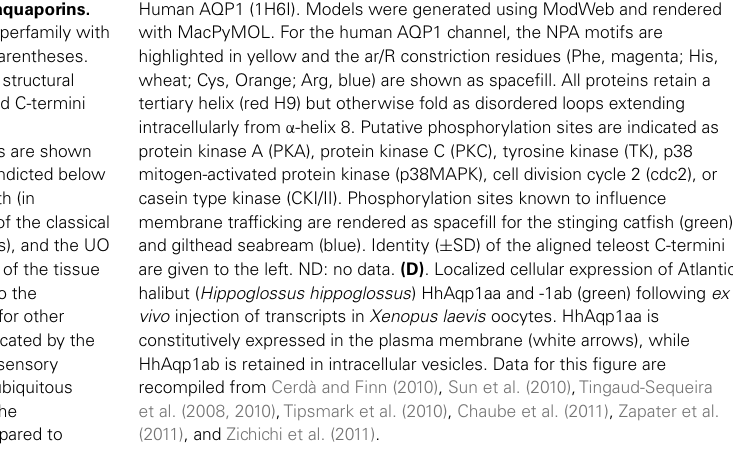
Human AQP1 (1H6I). Models were generated using ModWeb and rendered with MacPyMOL. For the human AQP1 channel, the NPA motifs are highlighted in yellow and the ar/R constriction residues (Phe, magenta; His, wheat; Cys, Orange; Arg, blue) are shown as spacefill. All proteins retain a tertiary helix (red H9) but otherwise fold as disordered loops extending intracellularly from α -helix 8. Putative phosphorylation sites are indicated as protein kinase A (PKA), protein kinase C (PKC), tyrosine kinase (TK), p38 mitogen-activated protein kinase (p38MAPK), cell division cycle 2 (cdc2), or casein type kinase (CKI/II). Phosphorylation sites known to influence membrane trafficking are rendered as spacefill for the stinging catfish (green) and gilthead seabream (blue). Identity ( ± SD) of the aligned teleost C-termini are given to the left. ND: no data. (D) . Localized cellular expression of Atlantic halibut ( Hippoglossus hippoglossus ) HhAqp1aa and -1ab (green) following ex vivo injection of transcripts in Xenopus laevis oocytes. HhAqp1aa is constitutively expressed in the plasma membrane (white arrows), while HhAqp1ab is retained in intracellular vesicles. Data for this figure are recompiled from Cerdà and Finn (2010), Sun et al. (2010),Tingaud-Sequeira et al. (2008, 2010),Tipsmark et al. (2010), Chaube et al. (2011), Zapater et al. (2011), and Zichichi et al.